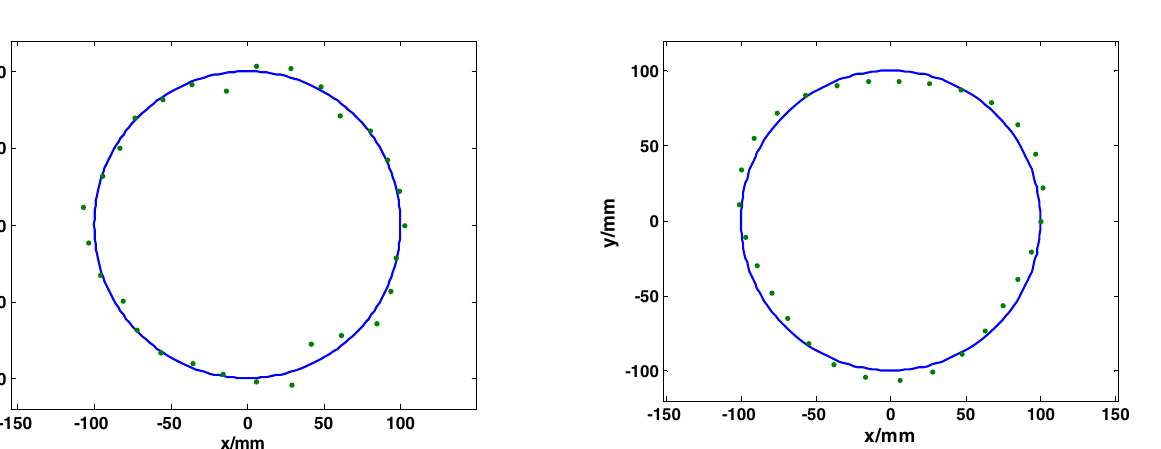
Fig. 1. Data generated using the null space approach for a least squares circle fit to data.